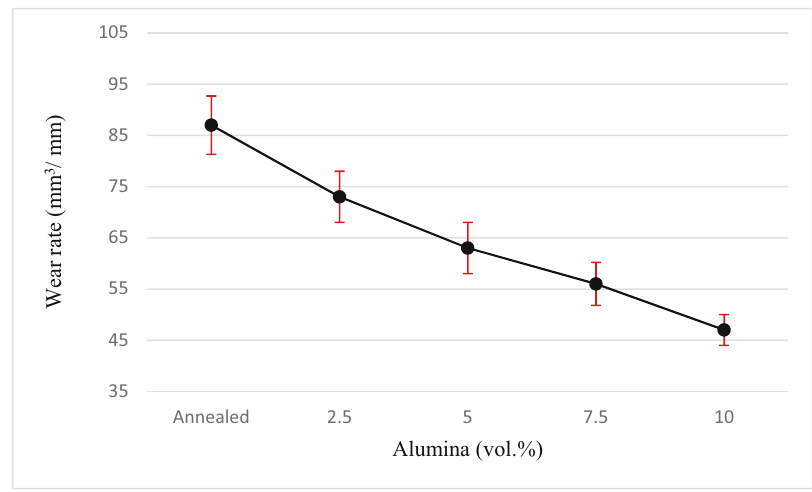
Figure 9: Wear rate in sliding wear for Al/alumina composite vs alumina volume content.